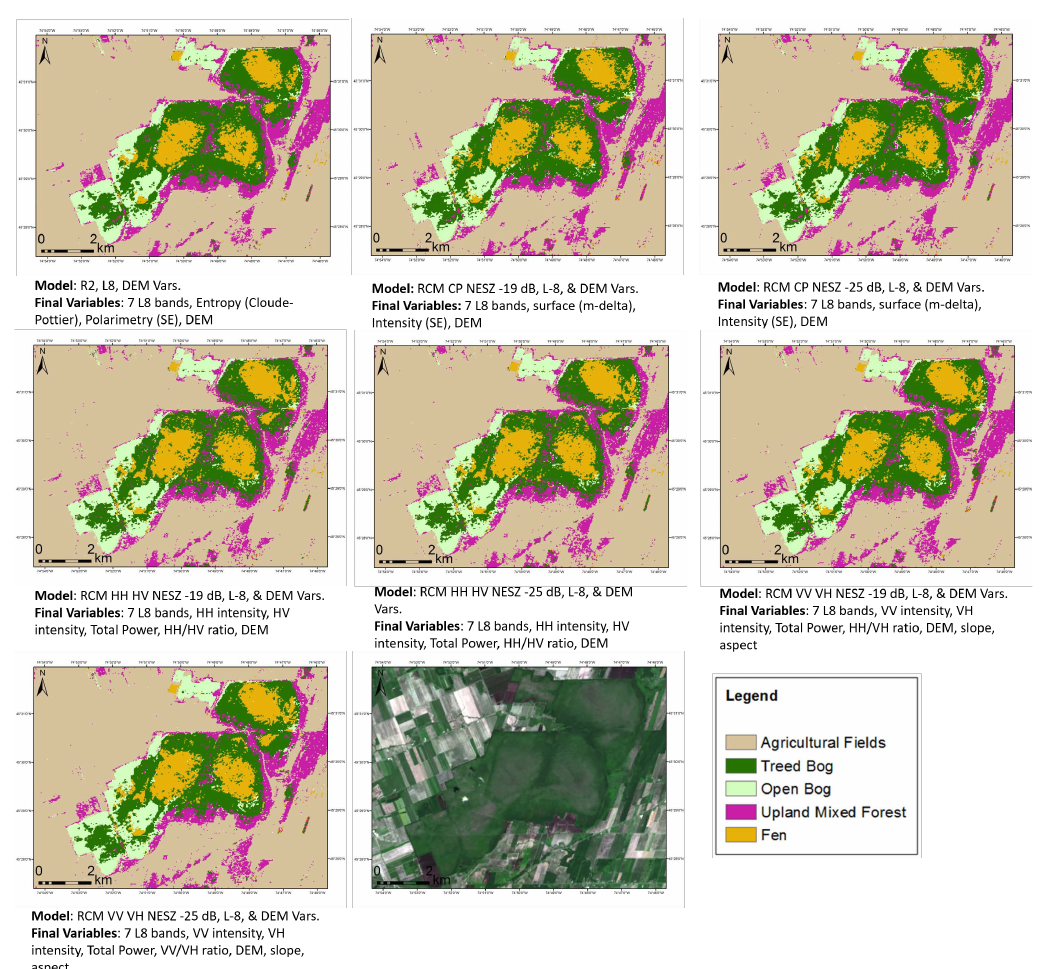
Figure 5. Visual results of the spring RF classifications. Models presented here were those with highest overall independent accuracy after variable reduction. A Landsat-8 image from 27 June 2014 was included for